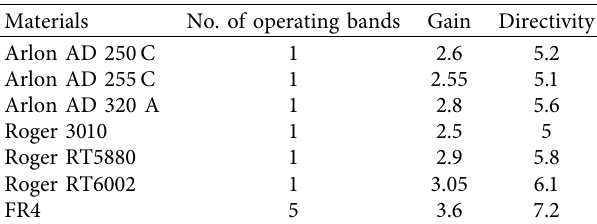
Figure 4: Return loss performance for various substrate materials. Table 2: Various materials and their effects on electromagnetic properties.